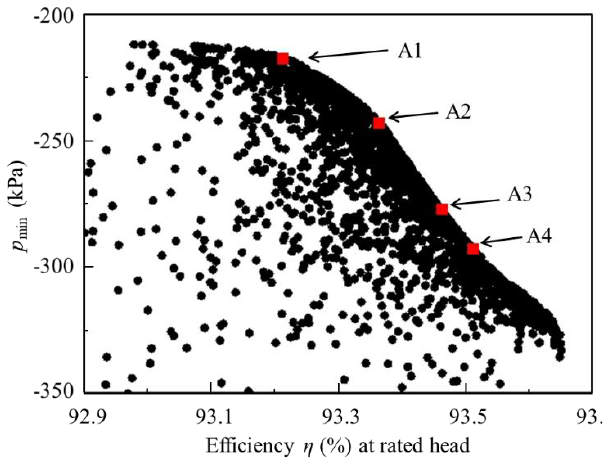
Figure 8. Obtained runners in first step optimization .